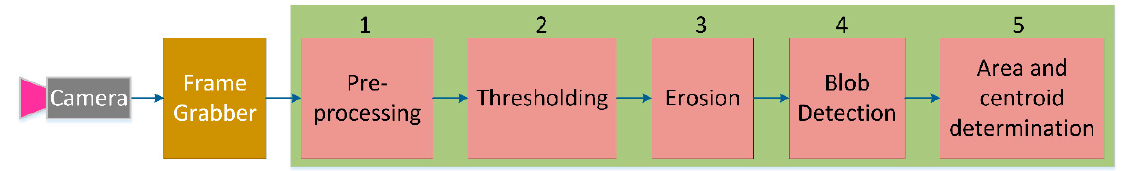
Figure 1. System components.